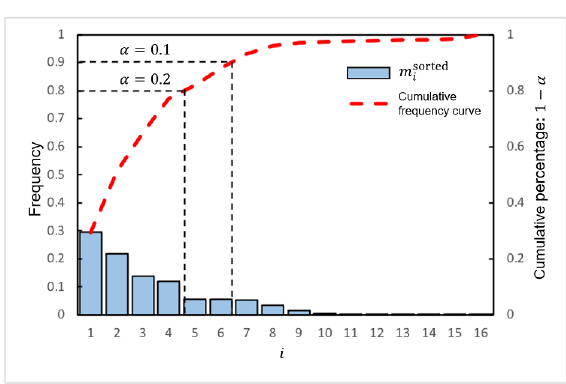
Figure 7. Pareto chart of parameter α and sorted histogram M sorted